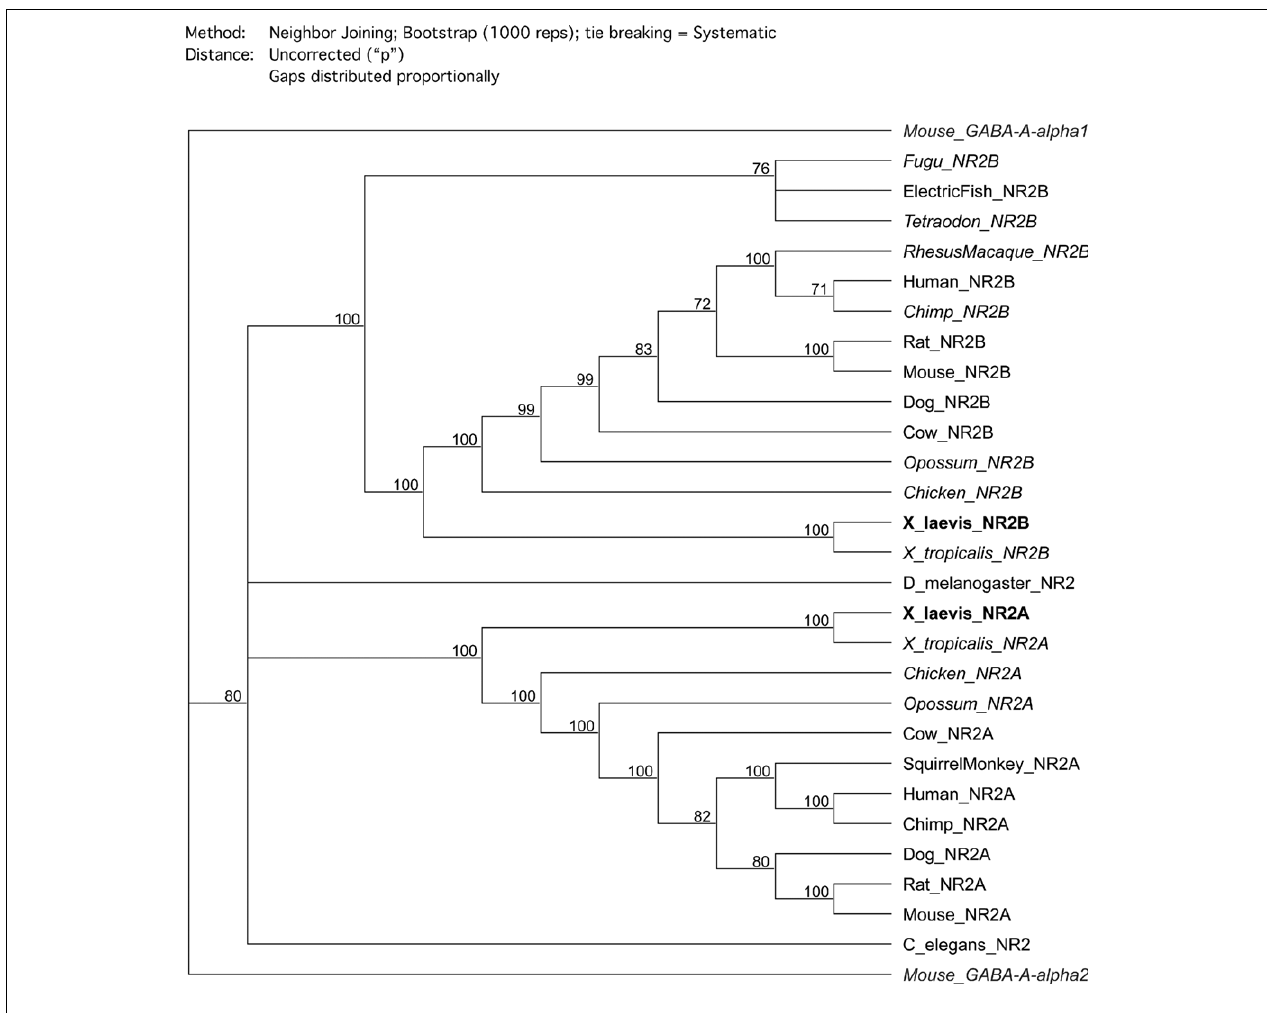
are shown at the nodes. The trees were rooted by aligning two unrelated sequences, mouse GABA-A-a1 and GABA-A-a2 ( gray italics ). The cloned X. laevis NR2A and NR2B are bold , sequences that were assembled by hand are in italics and the remaining sequences have GenBank accession